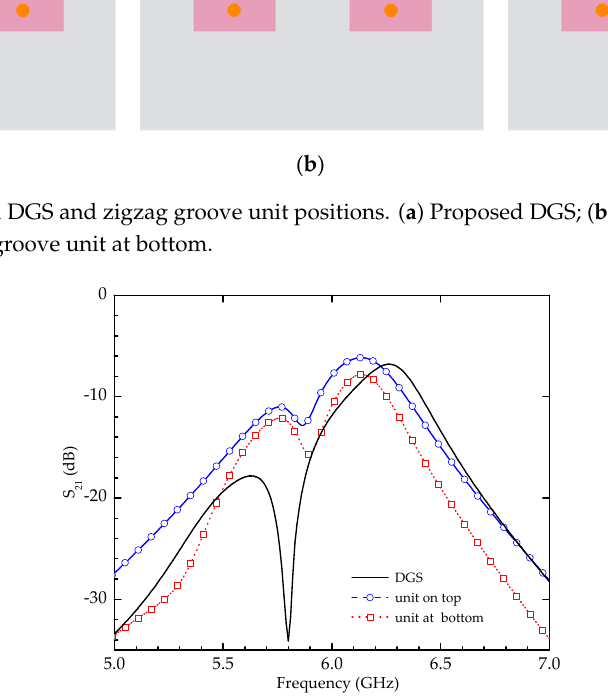
Figure 9. S 21 of DGS and zigzag groove unit in different positions at 5.8 GHz.